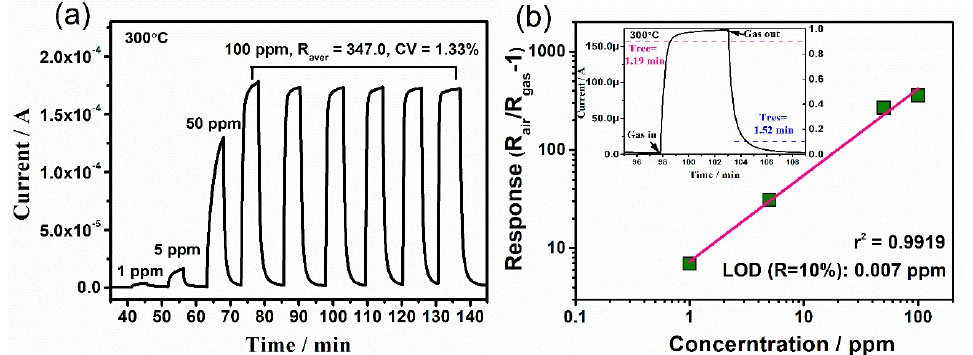
Figure 12. ( a ) Typical response-recovery current curves toward acetone gas with different concentration, ( b ) log-log plots of concentration-responses of N-incorporated SnO 2 gas sensor (the inset is the response and recovery time for the curve toward 100 ppm of acetone).